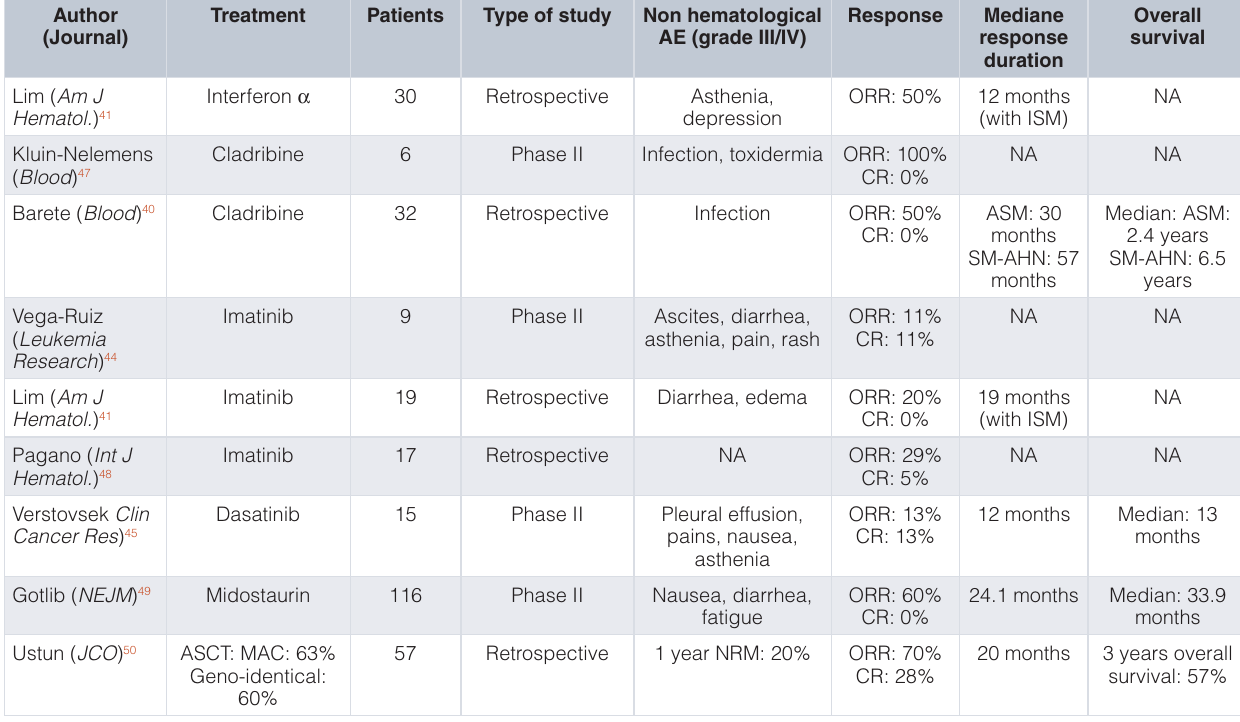
Table 4. Completed clinical trials and large retrospective studies for advanced